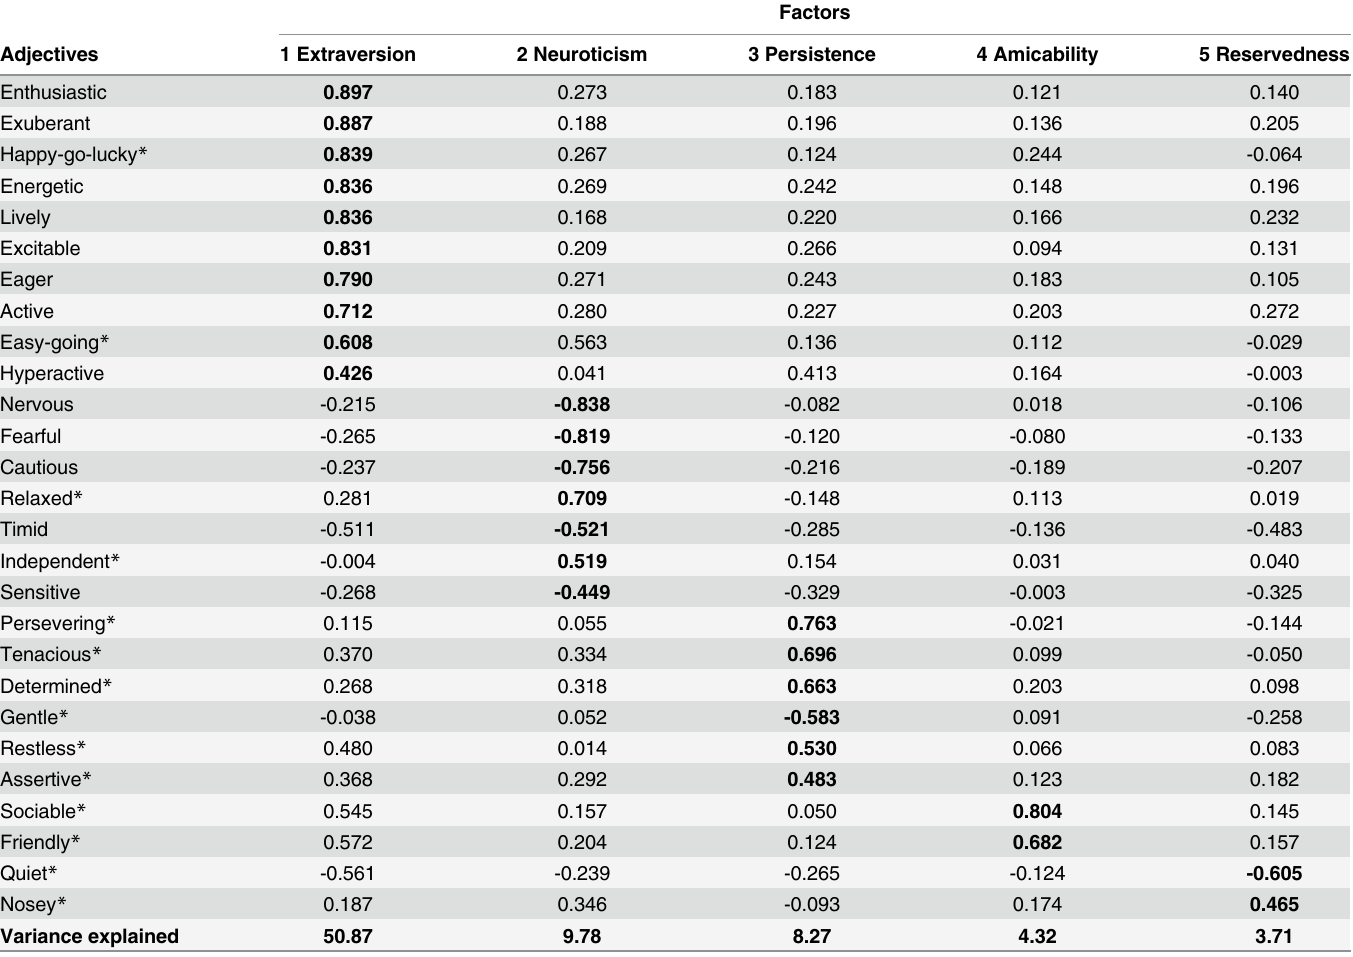
Table 5. Factor loadings from the questionnaire-based confirmative factorial analysis. Factor loadings > 0.40 are in bold.